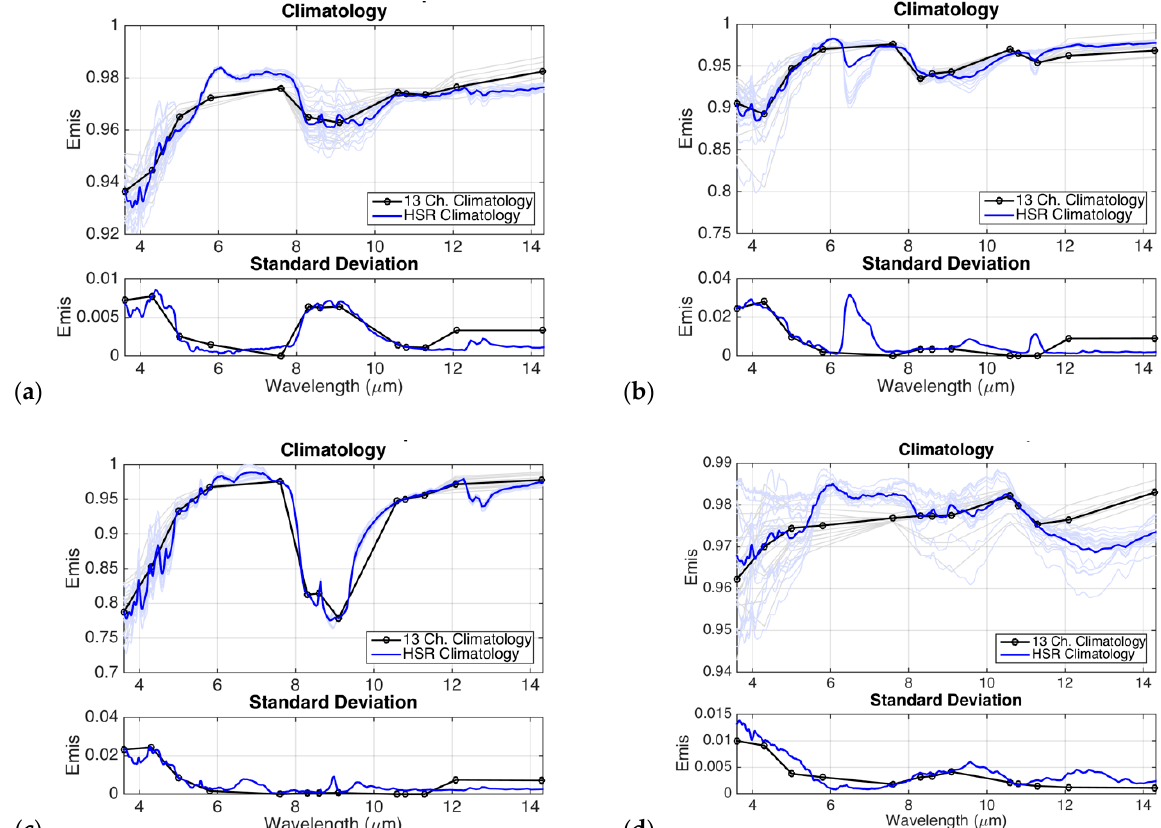
Figure 2. April 2000–2016 CAMEL 13 hinge-point monthly (grey) and climatology (black) emissivity overlaid with the HSR monthly (light blue) and climatology (blue) emissivity (top row), and standard deviation over the same years (bottom row) shown for the ( a ) Atmospheric Radiation Measurement (ARM) Southern Great Plains (SGP), ( b ) Yemen, ( c ) Namib, and ( d ) Rocky Mountain, Mt. Massive case site.